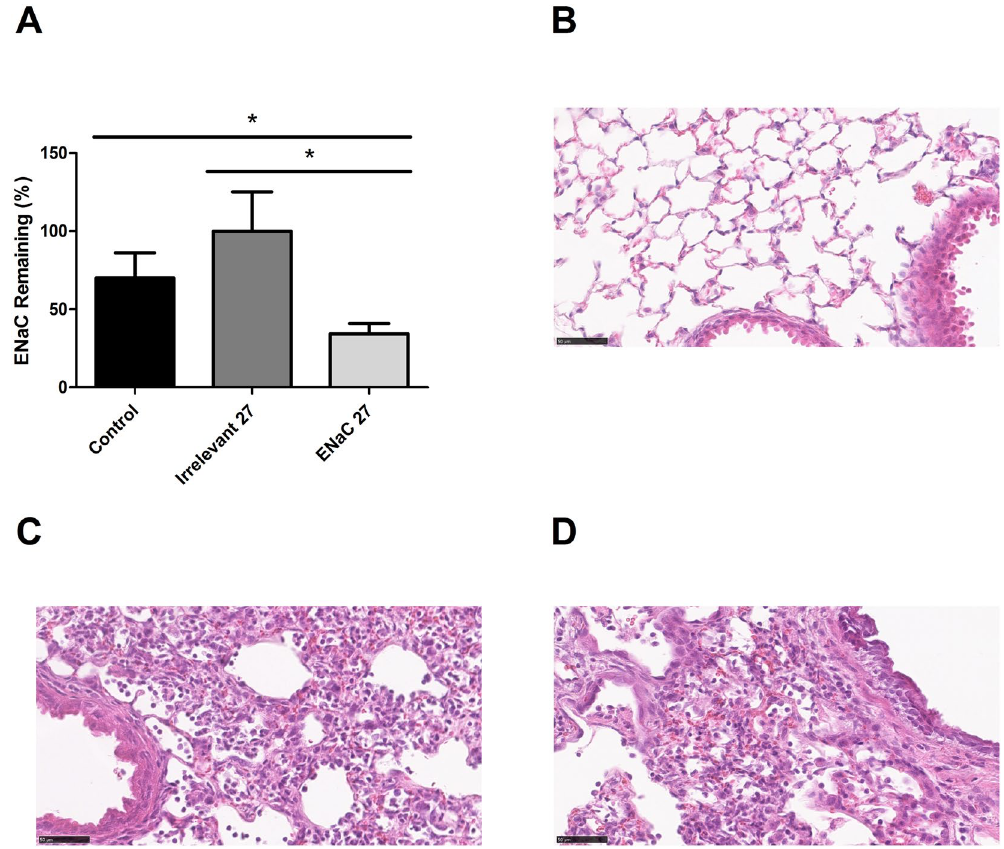
Figure 7. In vivo delivery of LPRs containing 27 μ g siRNA. ( A ) Following the LPRs administration, the knockdown in the expression of the α -ENaC gene mRNA in the lungs of C57BL6 female mice was measured by qRT-PCR. β actin was used as reference gene for mouse lung transcripts. The level of transcript expression of α -ENaC siRNA-treated group was compared with the control groups either untreated or non-targeting/ irrelevant siRNA treated cohorts. Statistical analysis was performed using Student’s t -test. Statistical significance is represented by * P < 0.05. ( B–D ) Representative images of H&E stained lung sections from untreated control ( B ), non-targeting/irrelevant siRNA-treated ( C ) and α -ENaC siRNA-treated ( D ) mice show a mild peribronchial mononuclear cell infiltration in siRNA-treated animals ( C , D ) compared with untreated controls ( B ). Scale bars = 50 µ